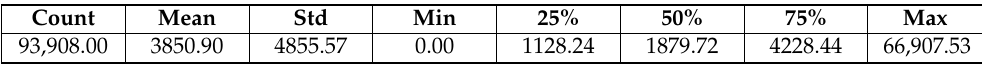
Table 1. EC25 variable: basic statistics. All values in µS/cm, except the count. Count Mean Std Min 25% 50% 75% Max 93,908.00 3850.90 4855.57 0.00 1128.24 1879.72 4228.44